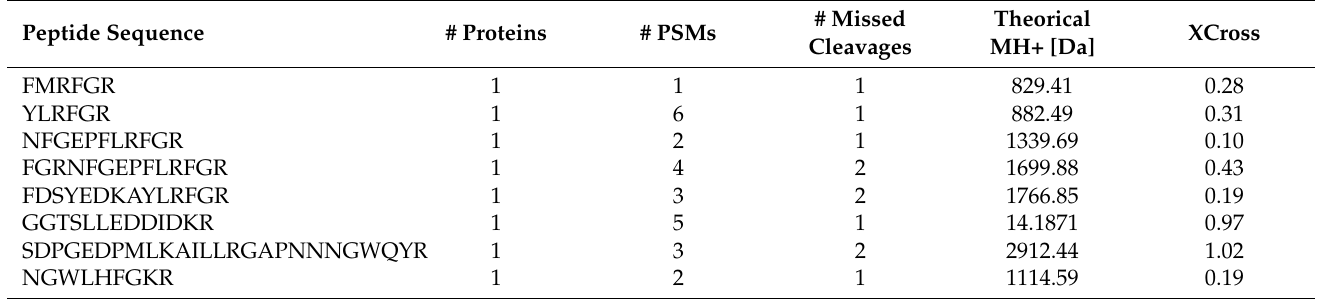
Table 3. Peptides related to Hdh-FMRF2 identified from the cerebral ganglion (CG) of Pacific abalone by LC-MS/MS